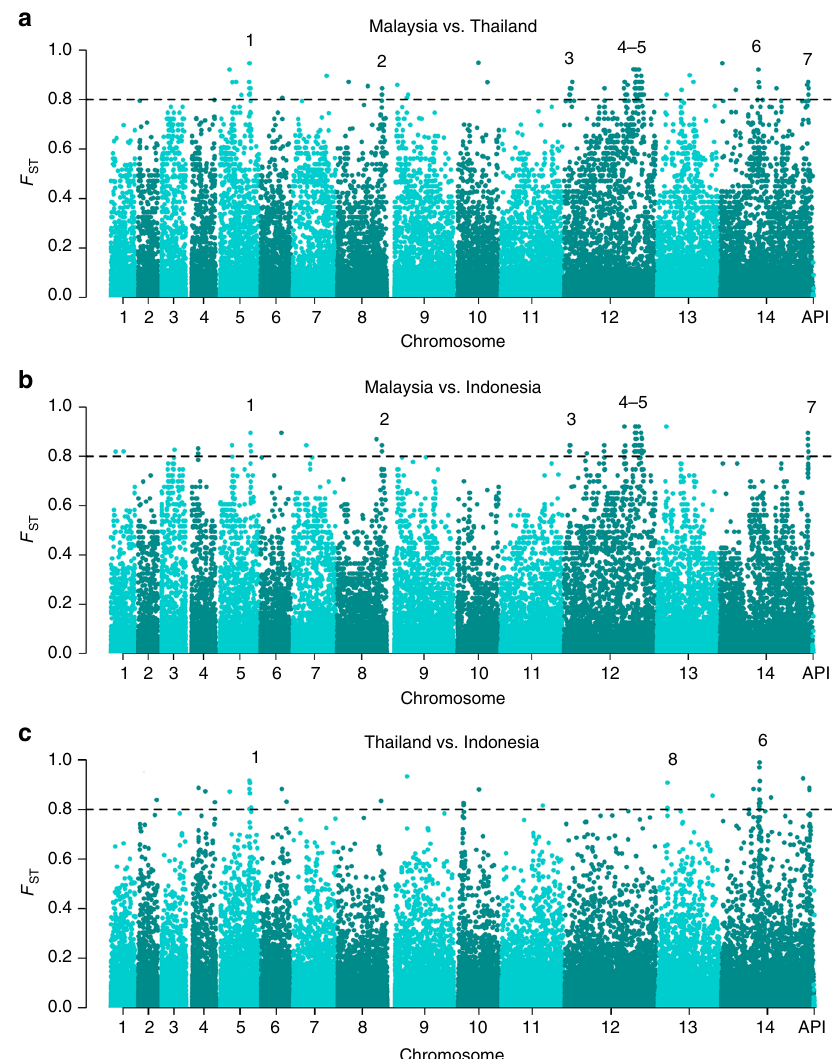
Fig. 4 Genetic differentiation between Malaysia, Thailand and Indonesia. a – c Manhattan plots illustrating the F ST between Malaysia (Sabah), Thailand and Indonesia. The Sabah population included a single K2 representative and excluded the three imported cases. Horizontal dashed lines illustrate F ST = 0.8. A total of 97 and 76 positions exhibited F ST scores ≥ 0.8 between Sabah and Thailand and Indonesia, respectively; 27 and 19 conferring non-synonymous changes. Seven multi-SNP regions identi fi ed in comparisons against Sabah are labelled: these regions comprise ≥ 3 SNPs with F ST ≥ 0.8 within 80 kb of one another. Region 1 encompasses DHFR-TS . Region 2 contains two genes on chromosome 8 with unknown function (PVP01_0834900 and PVP01_0835000). Region 3 is located on chromosome 12 and includes a nucleoside transporter ( NT1 ) with a highly differentiated L188M mutation between Sabah and Thailand, but not Sabah and Indonesia. Regions 4 and 5 are located adjacently on chromosome 12, corresponding with the highly homologous Sabah sequence. The regions contain biologically plausible drug resistance candidates including MDR2 and haeme detoxi fi cation protein ( HDP ). Another notable gene is GEST , implicated in transmission between the parasite and both its Anopheline and human hosts 37 . Region 6 encompasses DHPS . Region 7 is located on chromosome 14, encompassing 7 genes but with no clear driver of selection. Region 8 contains several SNPs on chromosome 13 exhibiting differentiation between Thailand and Indonesia only. The region encompasses the cysteine repeat modular protein 3 ( CRMP3 ). In addition to GEST and CRMP3 , two other genes with roles in host cell invasion or egress displayed highly differentiated variants; CRMP1 and glideosome-associated protein 40 ( GAP40 ). Signatures of selection between southeast Asian and South American P. vivax populations have previously been observed in CRMP1 26 , but this is the fi rst report of selection in GEST and differential levels of linkage disequilibrium (LD) surrounding the signal on chromosome 10, potentially re fl ecting selection on ancestral ( P. cynomolgi ) relative to the derived allele. Derived MSP3.2 26 . The second region comprised SNPs in the chromo- alleles could be con fi dently called at only 10,167 loci and, after some 12 region with high homology in Sabah. The third fi ltering out non-informative loci, the homology in Sabah proved region presents a signal on chromosome 13, possibly driven by too extensive to permit iHS analysis in this population alone. The selection on plasmepsin IV . The fourth region overlaps with a analysis was therefore conducted on the pooled Sabah, Thai and previously described signal on chromosome 14 postulated to Indonesian samples. Four regions were supported by multiple re fl ect selection on an AP2 domain transcription factor SNPs amongst the top 0.5% of scores (Fig. 5d and Supplementary (PVP01_1418100) 13 . Further details are presented in Supple- mentary Data 7. Data 4). The fi rst region overlaps with a previously described